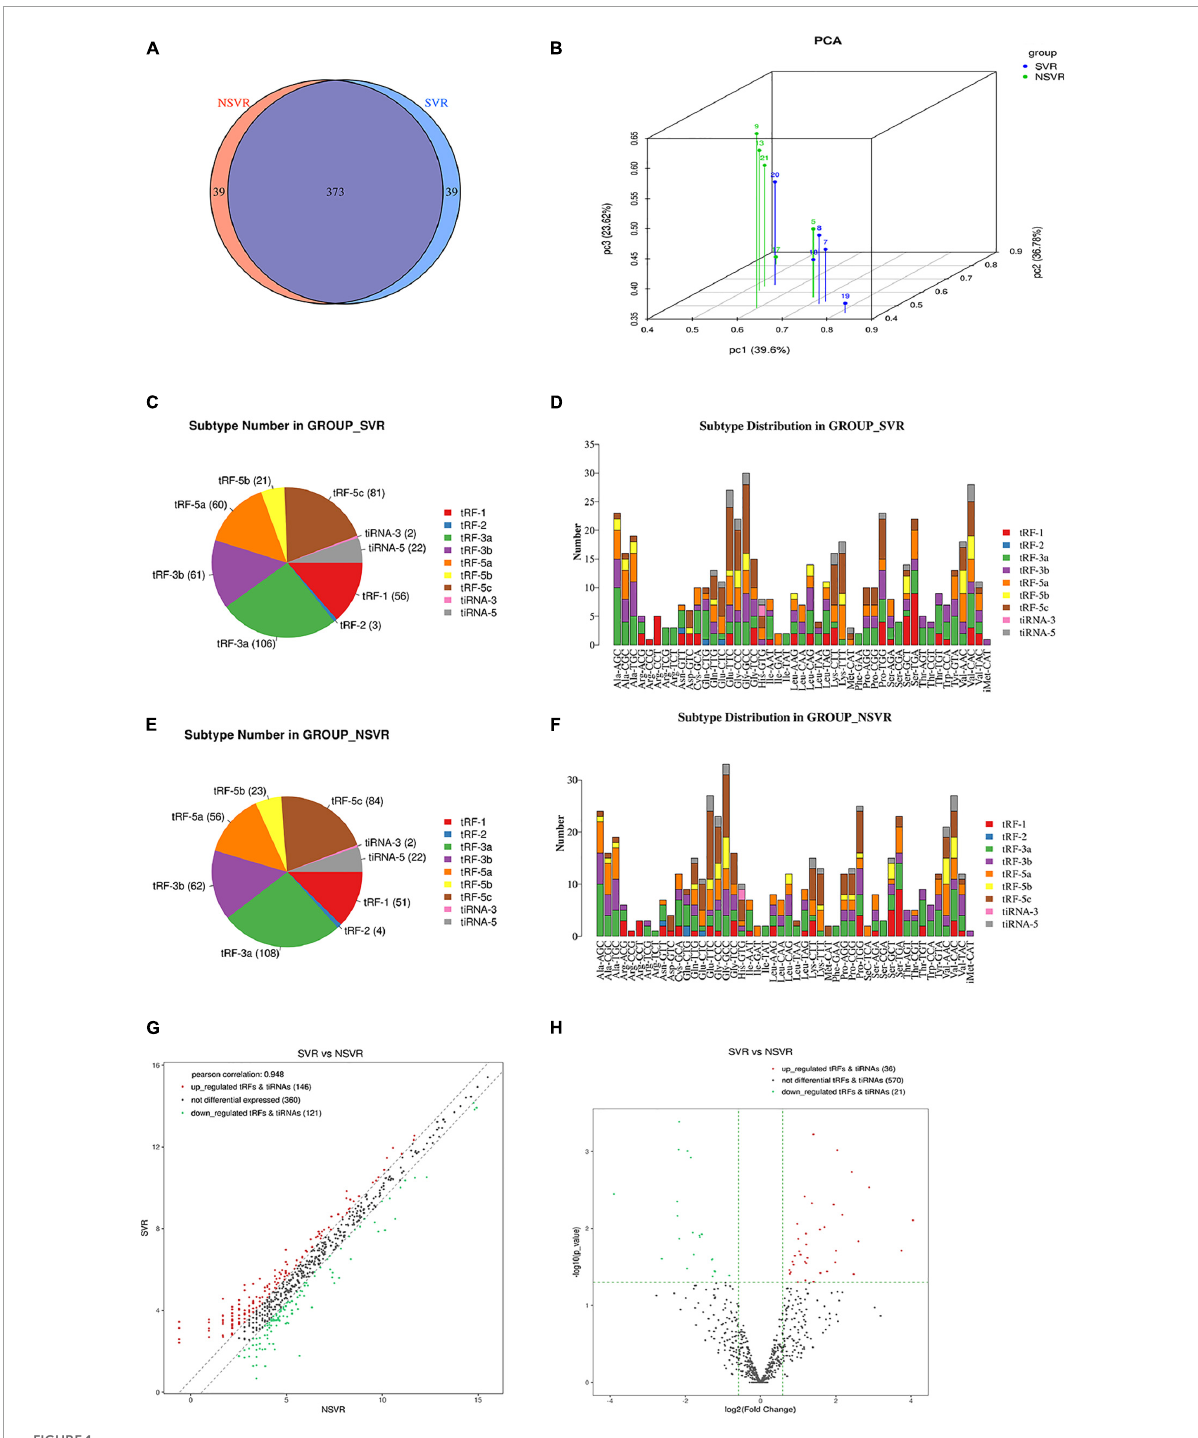
FIGURE1 Altered expression profiles of tsRNAs in SVR and NSVR patients. (A) The Venn diagram shows the number of tRFs and tiRNAs expressed in SVR and NSVR patients. (B) Principal component analysis. The PCA was performed with tRF and tiRNA that have the ANOVA P -value ≤ 0.05 on CPM value and showed a distinguishable tRF and tiRNA expression profiling among the samples. The X , Y , and Z axis represents the three main factors which affected the expression level of the sample. The colored point represents the corresponding sample, and the location of it shows the main character of the sample. Space distance represents the similarity of data size. (C) The number of subtypes of tRF and tiRNA against tRNA isodecoders in SVRs. (D) The distribution of tRF and tiRNA subtypes in SVRs. (E) The number of subtypes of tRF and tiRNA against tRNA isodecoders in NSVRs. (F) The distribution of tRF and tiRNA subtypes in NSVRs. (G) Scatter plot between the two groups for tRF and tiRNA. (H) Volcano plot of tRFs and